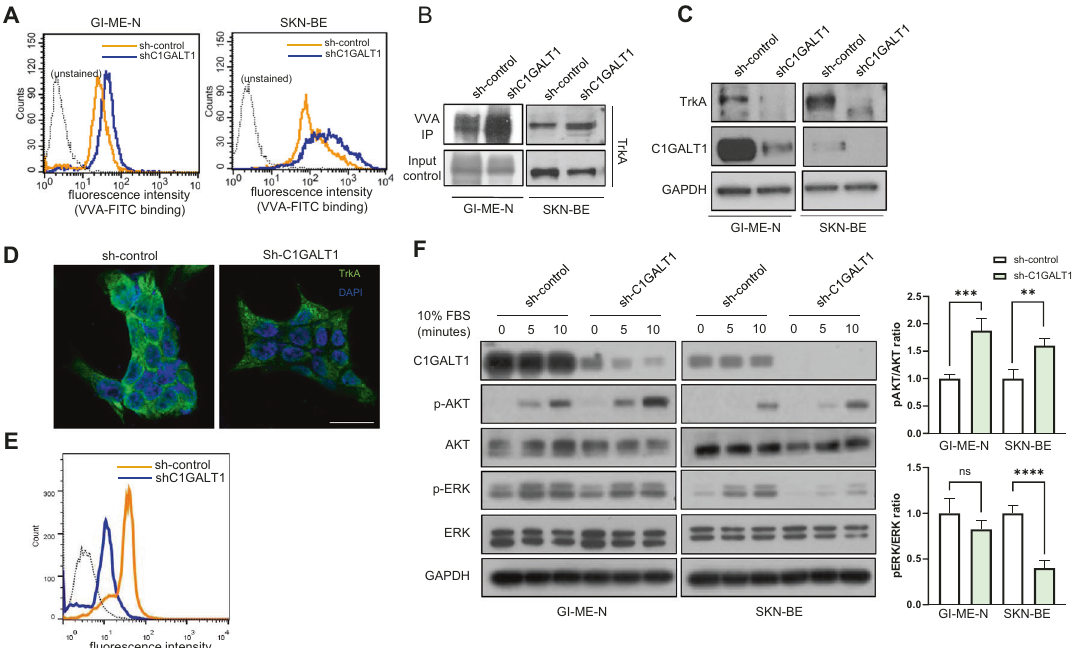
Fig. 3 Downregulation of C1GALT1-mediated O-glycan change regulates the protein expression and localization of TrkA and its downstream signaling. A – B C1GALT1 could modify the Tn antigen expression on TrkA in NB cells. A Representative histogram plots from three independent experiments are shown for fl ow cytometry with FITC-VVA lectin in GI-ME-N and SK-N-BE cells infected with shC1GALT1 or negative control lentivirus. B Total lysates were pulled down (PD) using VVA agarose beads and then immunoblotted with a TrkA antibody. C Expression of TrkA, C1GALT1, and GAPDH in whole lysates was shown by Western blotting. D – E Inhibition of C1GALT1 could regulate the localization of TrkA. D Representative immuno fl uorescence images taken from confocal microscope show the localization of TrkA (green) in cells. DAPI (blue) was used to stain the nucleus. Scale bar indicates 50 μ m. E Representative histogram plots showed TrkA expression levels at the cell surface measured by fl ow cytometry. F C1GALT1 knockdown decreased phosphorylation of ERK, but increased phosphorylation of AKT in GI-ME-N and SK-N-BE cells. Serum-starved cells were reintroduced with 10% FBS for different times as indicated. Western blots show the expression of AKT, p-AKT, ERK, p-ERK, C1GALT1, and GAPDH ( n = 3). The bar diagrams of the ratios of p-AKT/total AKT and p-ERK/total ERK were shown in the right panel. ** p < 0.01, *** p < 0.001, **** p < surface in SKN-BE cells (Fig. 3E). Because TrkA activates several signaling pathways responsible for the differentiation and proliferation of NB cells, we, therefore, hypothesized that the C1GALT1-mediated alteration in TrkA O-glycans may affect its downstream signaling. The immunoblotting results and the relative quanti fi cation of the ratios of p-AKT/total AKT and p- ERK/total ERK showed that the level of phosphorylated AKT was signi fi cantly increased in C1GALT1 knockdown cells, but attenu- ated the level of phosphorylated ERK, suggesting that inhibition of C1GALT1 is involved in sustained AKT signaling downstream of TrkA (Fig. 3F). TrkA signaling pathways are involved in the phenotypic changes mediated by C1GALT1 We next aimed to determine whether upregulation of C1GALT1 may contribute to the antitumor phenotypes of NB cells and promote neurite outgrowth through TrkA pathway. Overexpres- sion of C1GALT1 increased the protein levels of TrkA (Fig. 4A) and promoted the differentiation of NB cells with increased the growth of neurites, whereas knockdown of TrkA inhibited C1GALT1- induced neuronal differentiation (Fig. 4B). Moreover, the inhibitory effects of migration and invasion in C1GALT1-overexpressing NB cells were blocked by shRNA-mediated TrkA downregulation (Fig. 4C, D). Since the activation of ERK and AKT signaling are the major response of NGF/TrkA for neuronal cell differentiation and proliferation, respectively [39], we next analyzed the phosphoryla- tion levels of ERK and AKT in the C1GALT1-overexpressing and TrkA knockdown NB cells. Similar as C1GALT1 knockdown, the bar diagram of the ratios of p-AKT/total AKT and p-ERK/total ERK